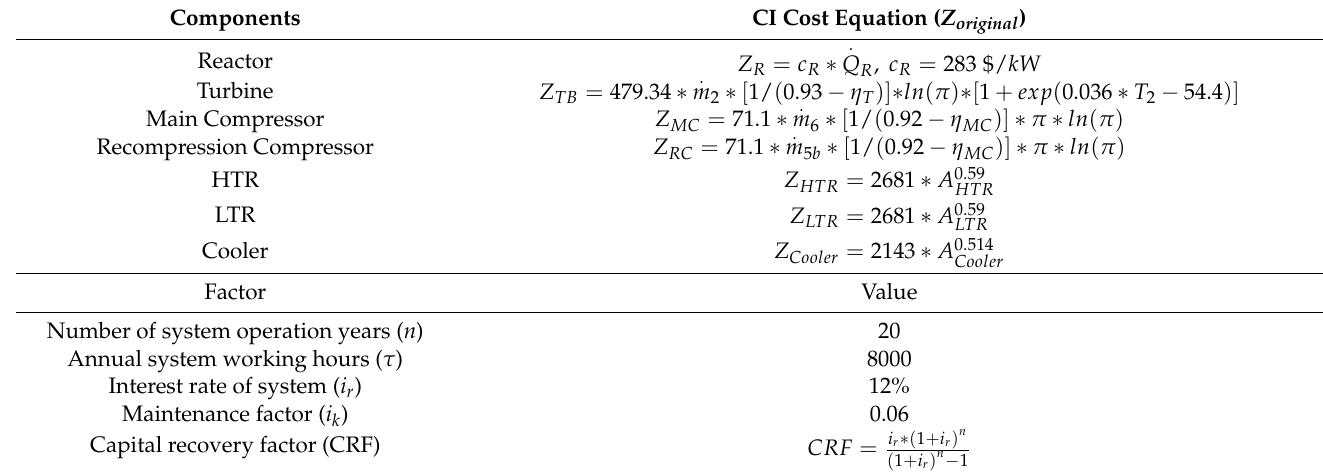
Table A2. CI cost equations and economic value of each component [37,38].